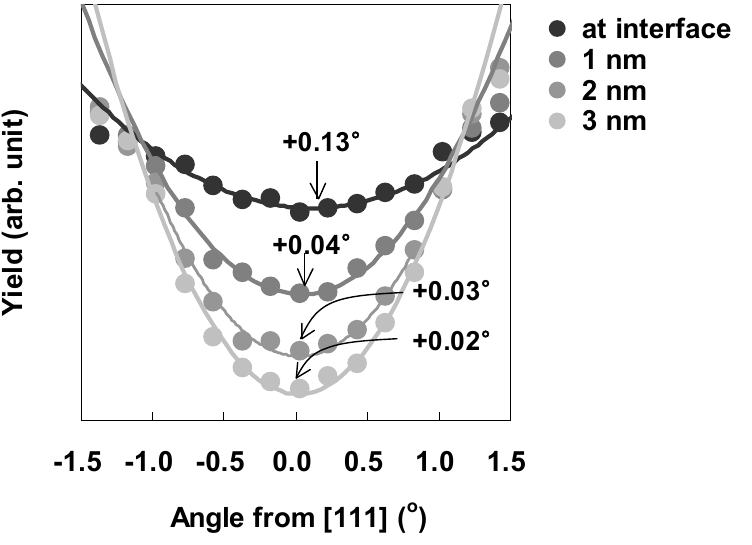
Figure 14. Depth dependence of the strain at the LaAlO